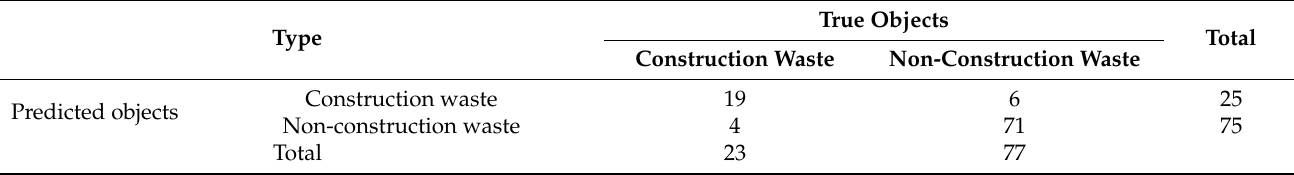
Table 4. The confusion matrix for area A.